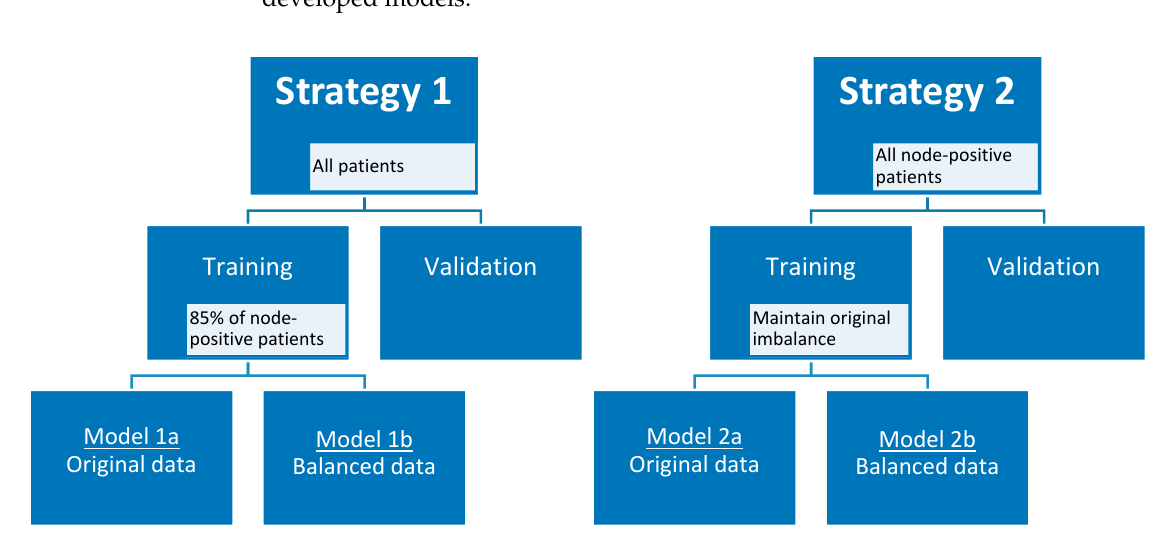
Figure 5. Model strategies.